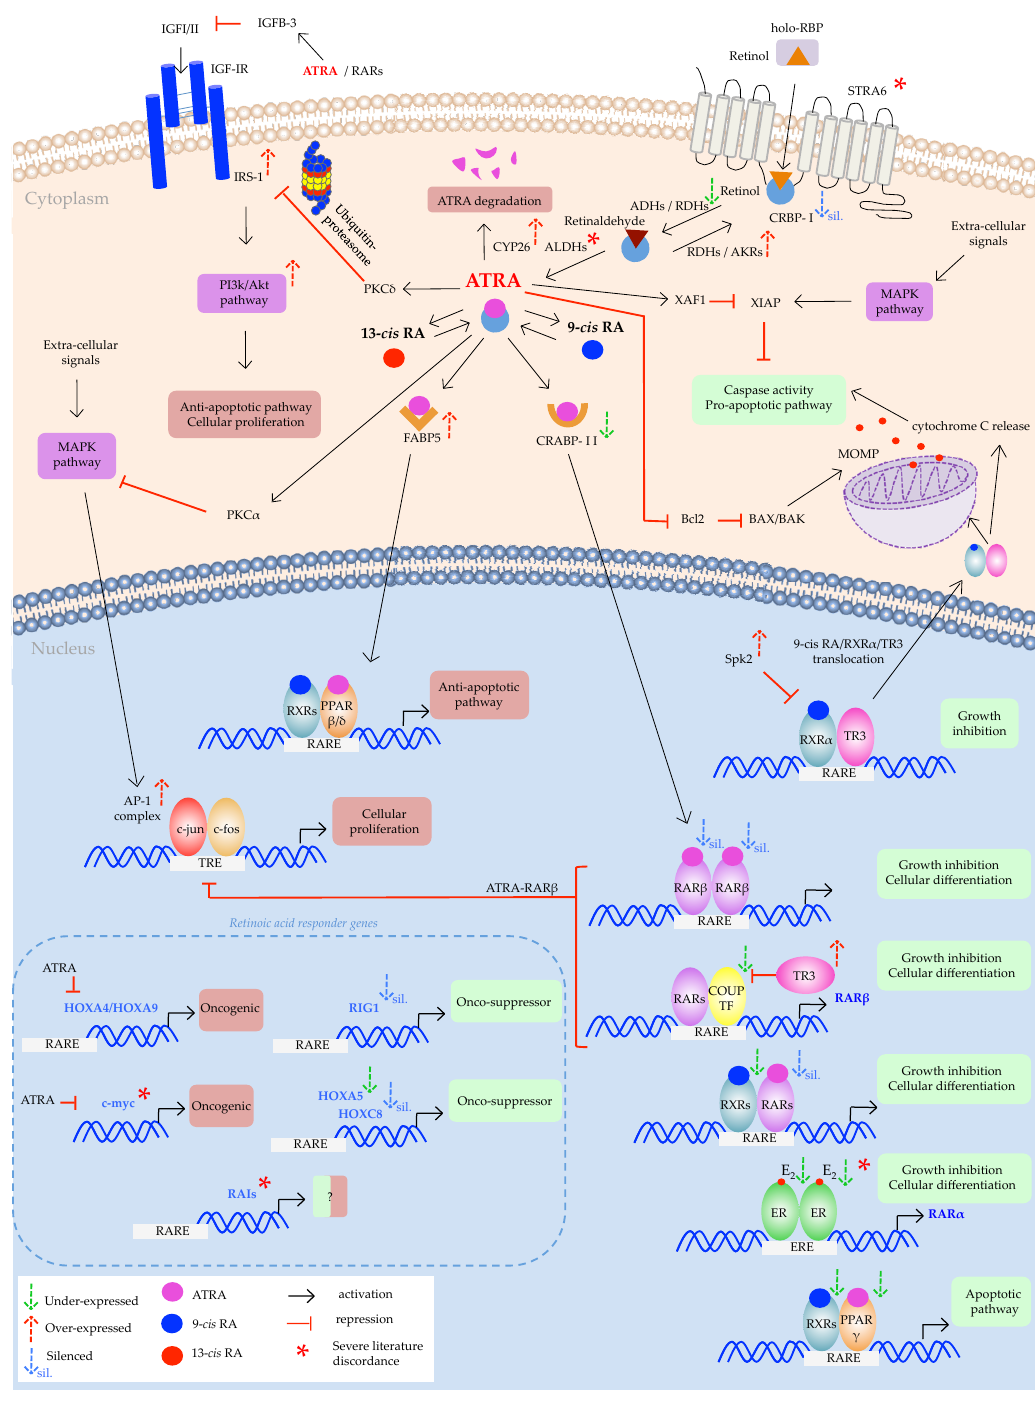
Figure 3. The main pathways in which retinoic acids are involved to induce cancer cell growth inhibition in ATRA-sensitive cell lines are illustrated. Moreover, molecules under-expressed, over-expressed, or silenced in ATRA-resistant cell lines are indicated. See the text for a detailed description. MOMP: mitochondrial outer membrane